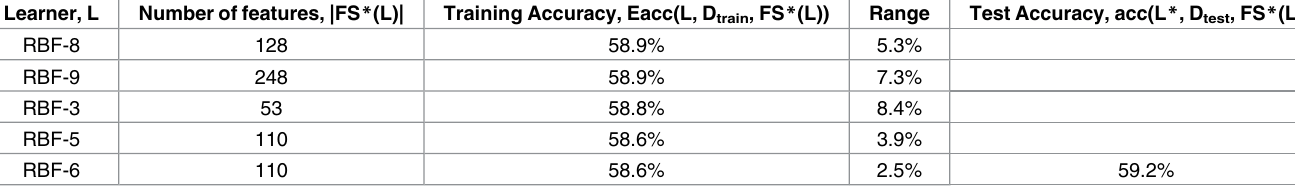
Table 6. ABIDE, functional